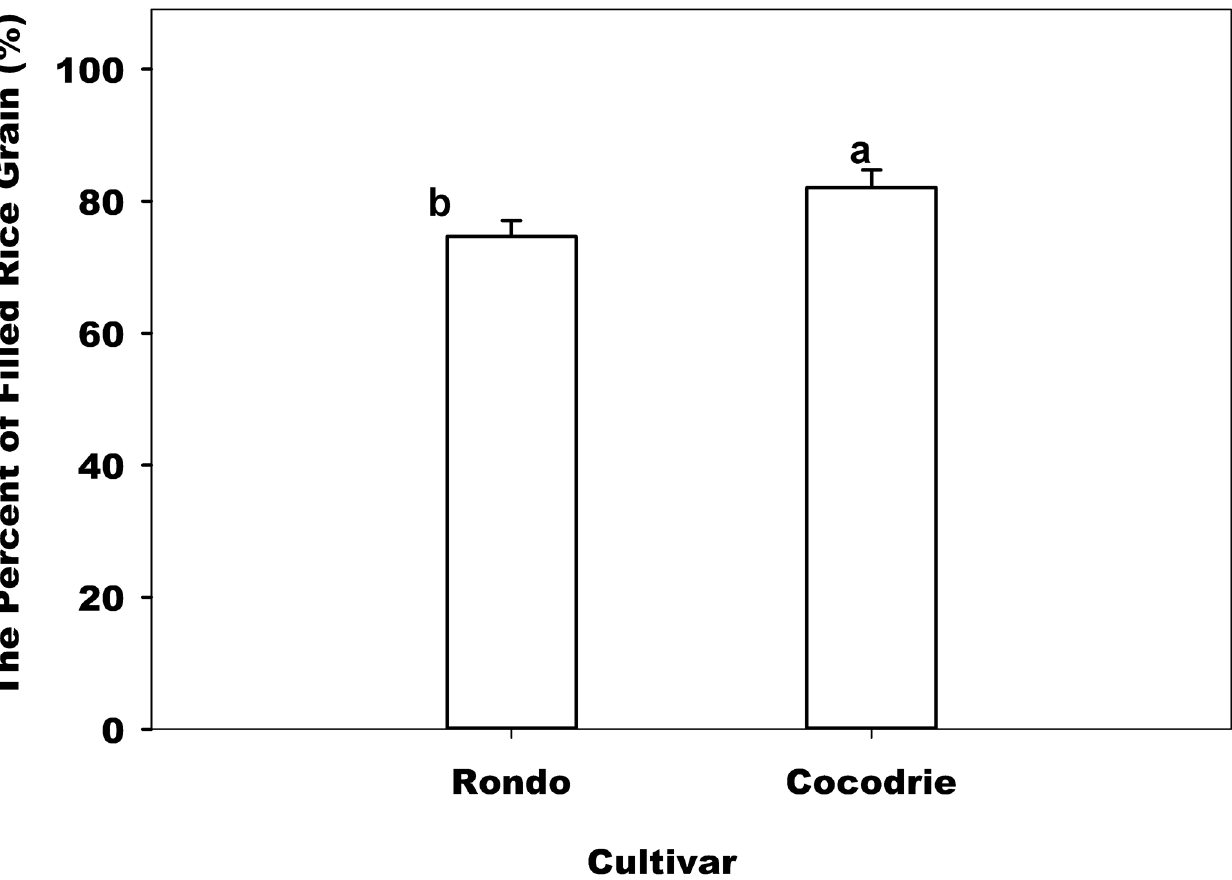
Fig 4. Effect of cultivar on the percentage of filled spikelet number at harvesting. Error bars denote the standard error of the mean. Bars with the same letters above are not significantly different based on Fisher ’ s protected LSD ( P = 0.05).